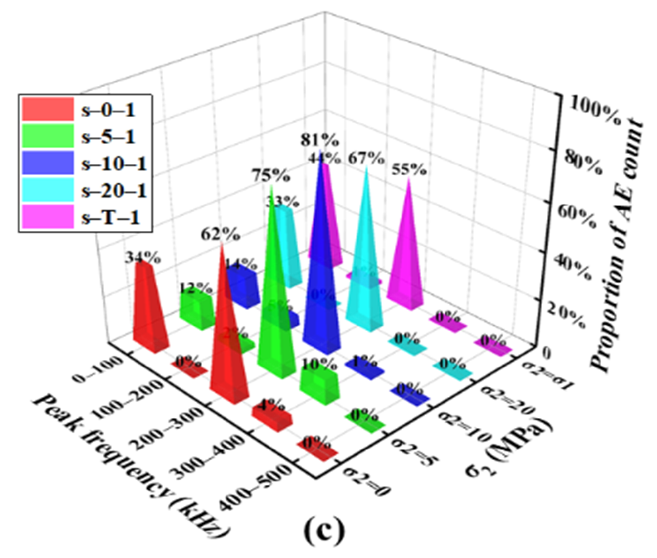
Figure 13. Peak frequency distributions of ( a ) granite, ( b ) marble, and ( c ) sandstone.